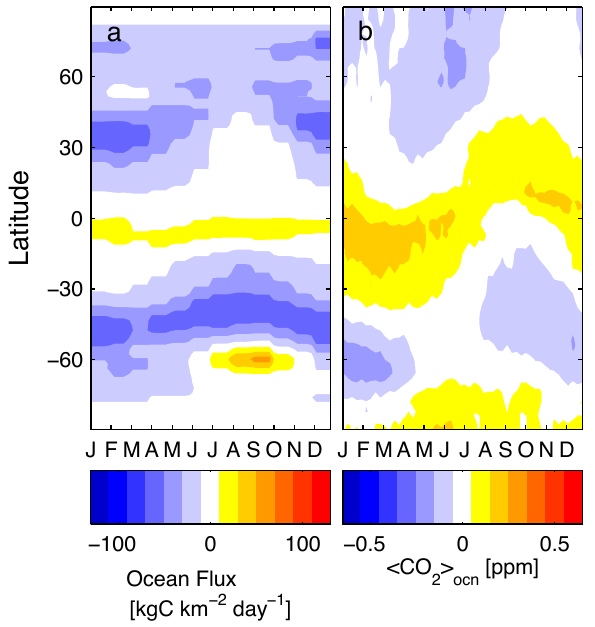
Fig. 2. (a) Ocean exchange as a function of latitude and month of the year. The scale has been reduced by a factor of 10 compared to NEE (Fig. 1), as ocean fluxes are smaller. (b) h CO 2 i ocn resulting from ocean exchange.